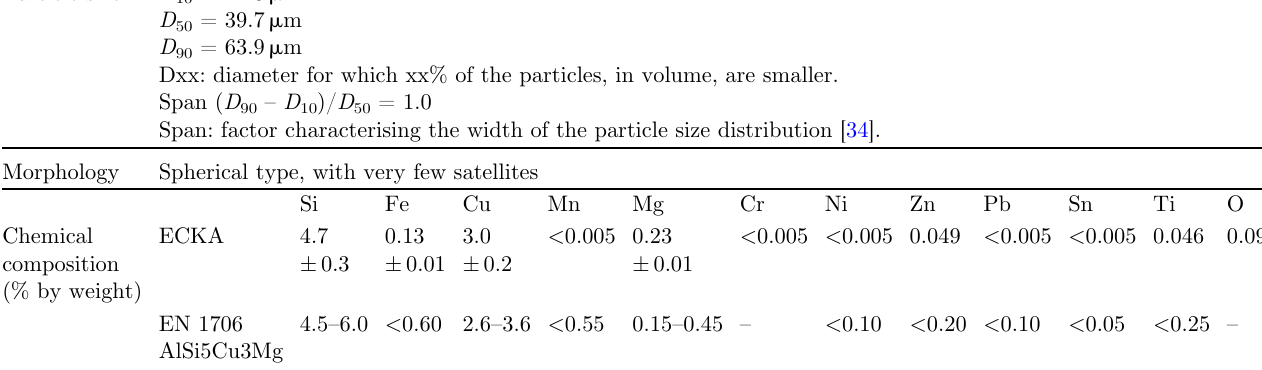
Table 1. Technical data of the AlSi5Cu3Mg alloy powder. Particle